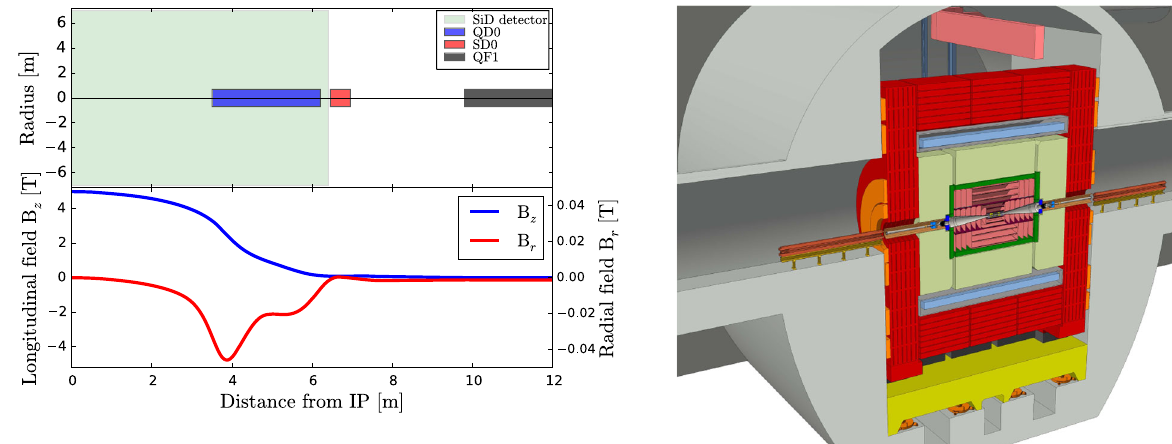
FIG. 2. Schematic overview of the SiD interaction region layout from the last 12 m of the FFS (upper plot). Simulation of the longitudinal and radial fields (bottom plot). QD0 overlaps with the SiD solenoid field for L (cid:1) ¼ 3 . 5 m.